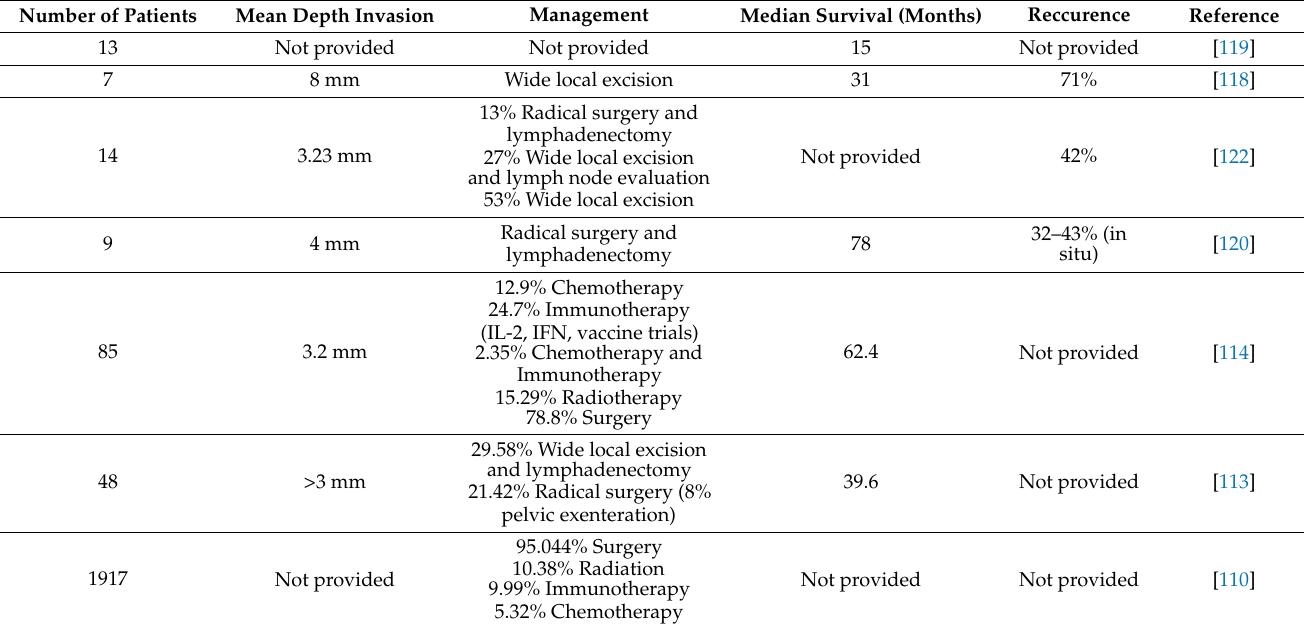
Table 6. Survival rates according to type of treatment